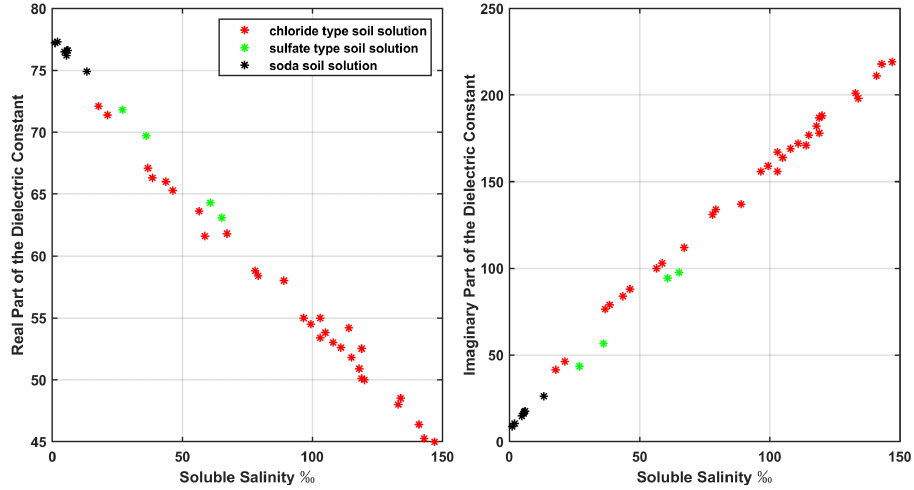
Figure 6. Real and imaginary parts of dielectric constant as a function of soluble salt content in